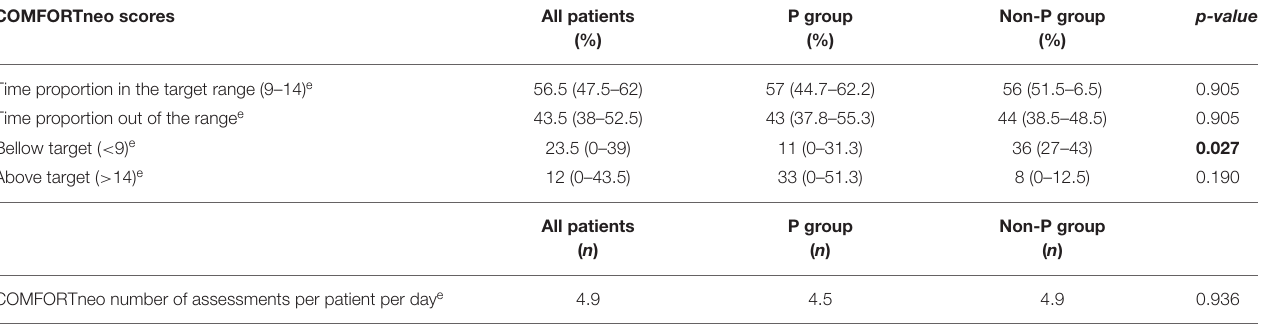
TABLE 2 | Primary endpoints: COMFORTneo pain assessment in treatment groups within 48h after surgery. COMFORTneo